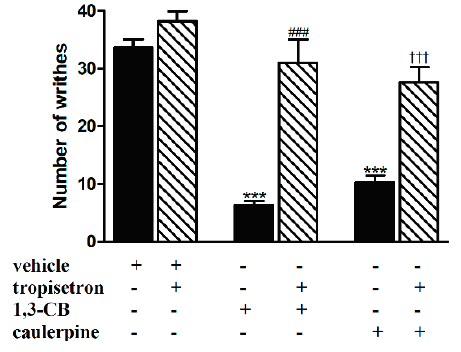
Figure 6. Effect of tropisetron on the antinociceptive effect of caulerpine in the acetic acid model of nociception. Black columns: treatments alone; hatched columns: pretreatment and treatments. The results are expressed as means ± S.E.M. of six animals. (One-way ANOVA followed by Bonferroni’s test). *** p < 0.001 compared to vehicle; ### p < 0.001 compared to 1,3-CB; ††† p < 0.001 compared to